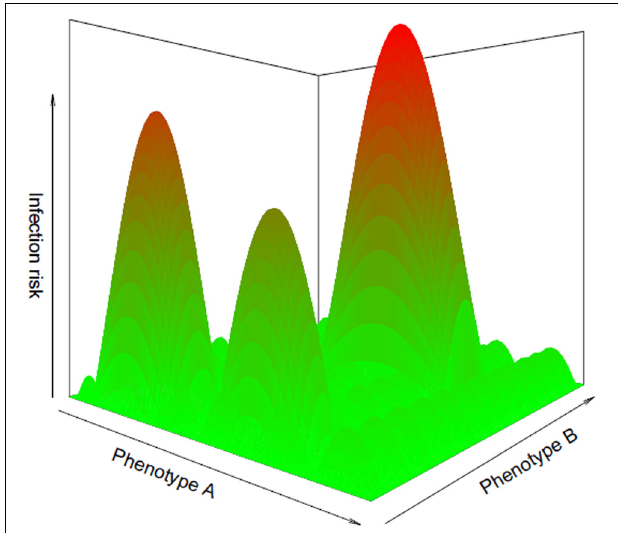
FIGURE 1 | Phenotypic landscape of infection risk, illustrating the infection risk associated with all possible combinations of values for two hypothetical phenotypic traits, A and B. Red peaks correspond to phenotypes exposing individuals to a high risk of infection, whereas green valleys correspond to safe phenotypic strategies. Species whose phenotypes settle in valleys over evolutionary time may eventually lose parasite species.